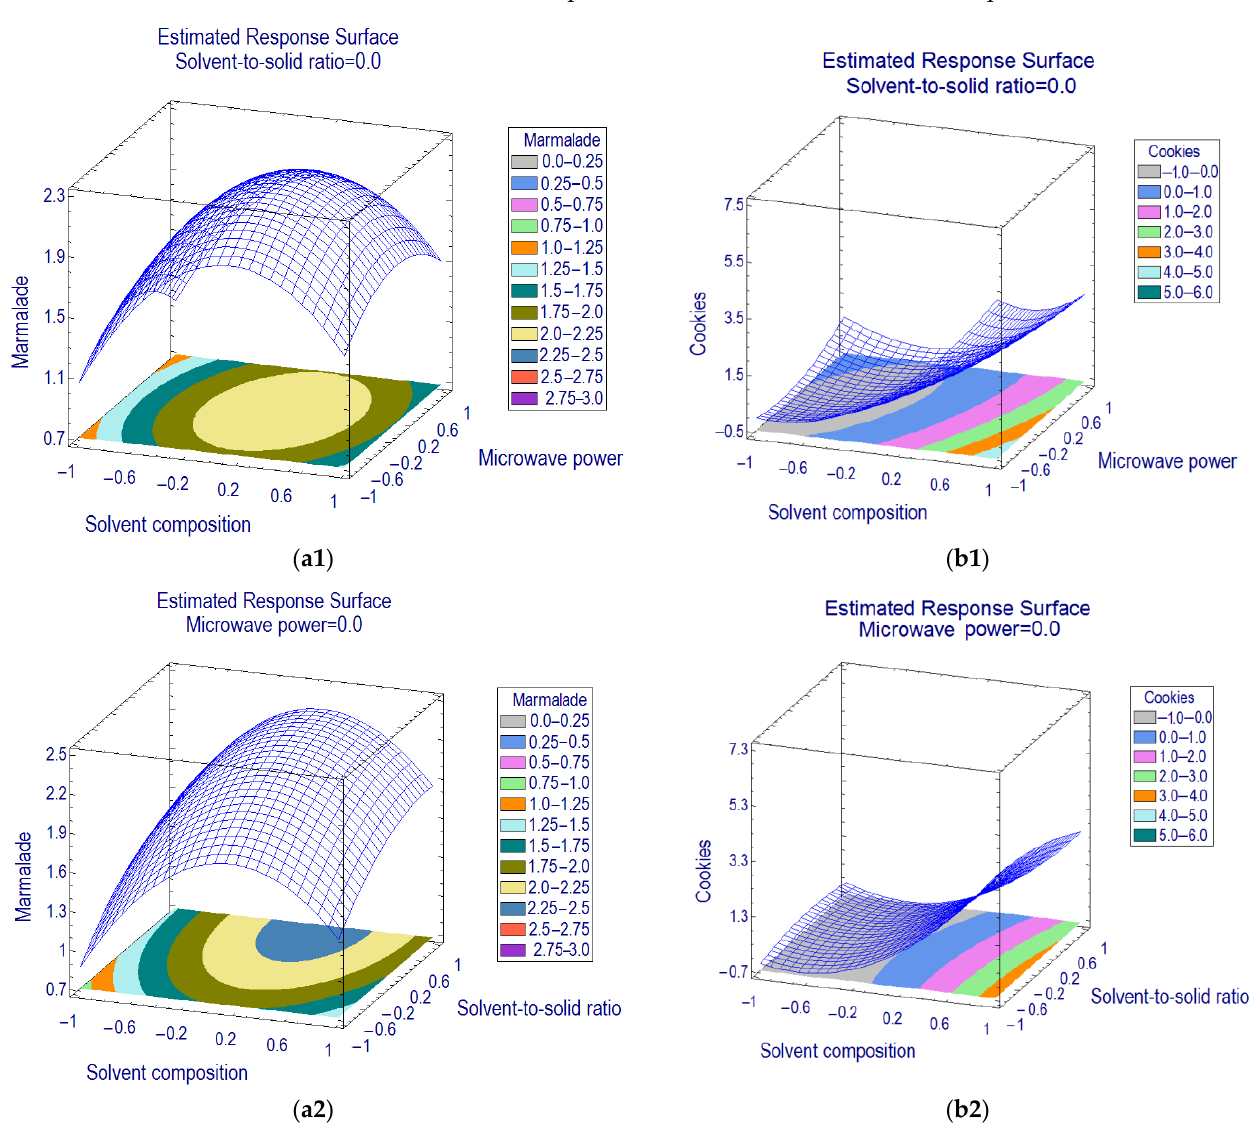
Figure 2. Response surface and contour plots displaying effects of MAE factors on the level of extracted resveratrol from ( a ) marmalade and ( b ) cookies.